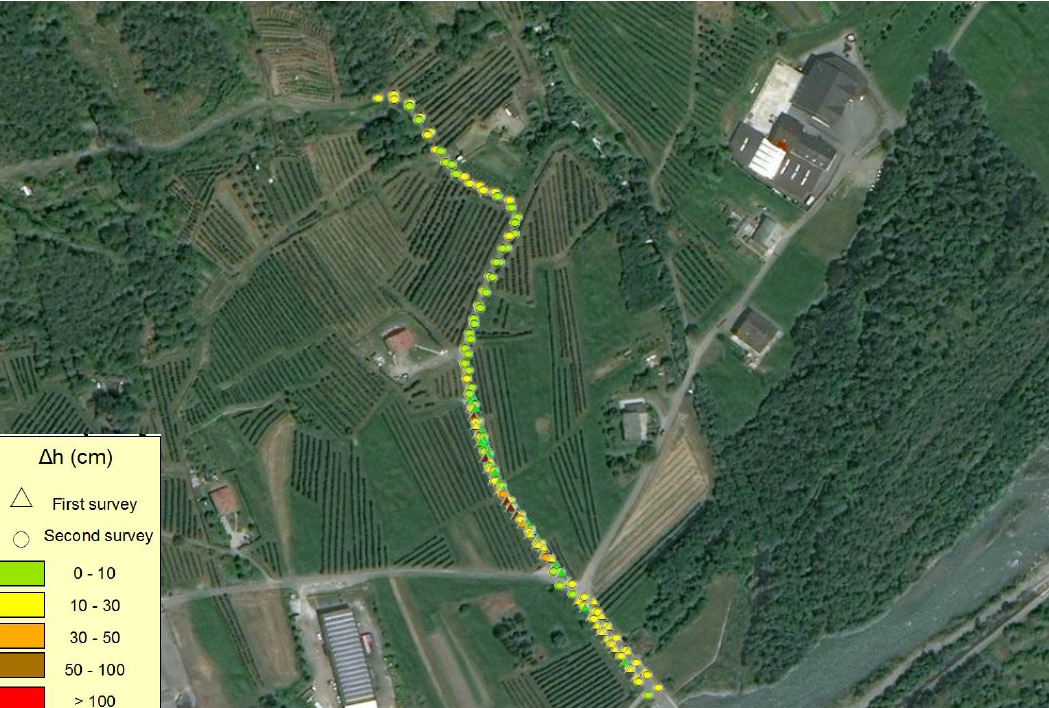
Figure 4. VT07 area: GNSS RTK results and differences with respect to HR DTM heights.